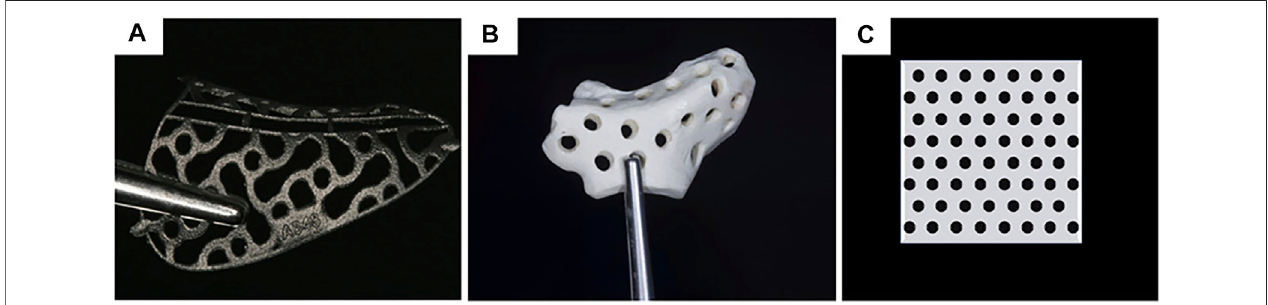
FIGURE 1 | Materials for customized mesh: (A) titanium alloy (Hartmann and Seiler, 2020); (B) PEEK (Mounir et al., 2019); (C) uHA/PLLA. Reproduced with permission from (Hartmann and Seiler, 2020) and (Mounir et al., 2019).